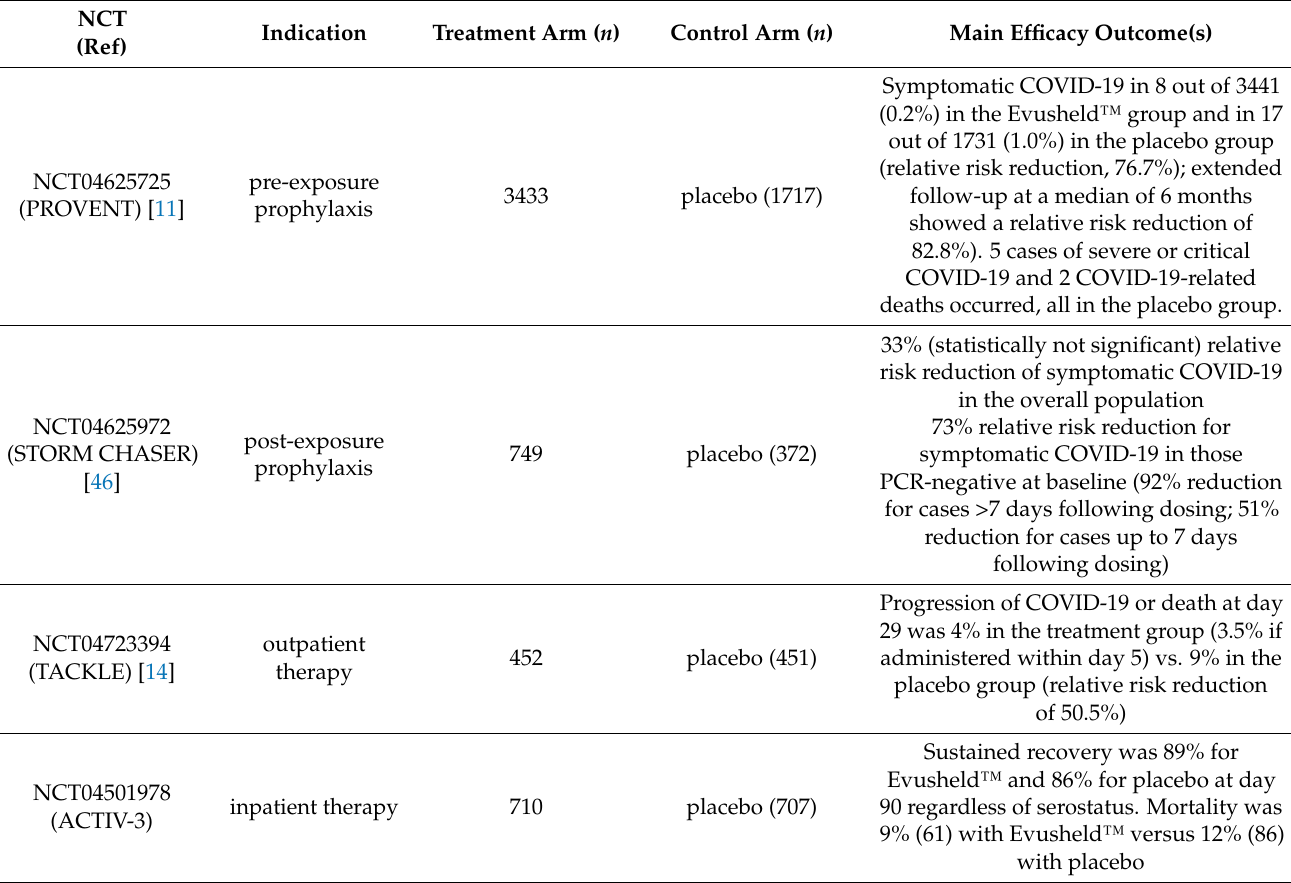
Table 1. Synopsis of randomized controlled trials using